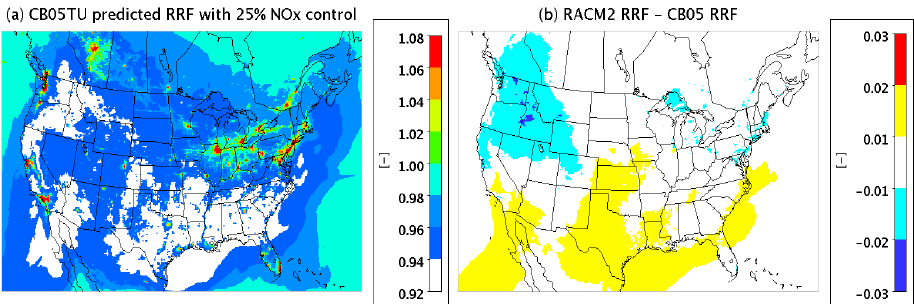
Fig. 12. (a) Relative Reduction Factors for ozone obtained with CB05TU due to 25% NO x control, (b) differences in Relative Reduction Factors for ozone between RACM2 and CB05TU due to 25% NO x